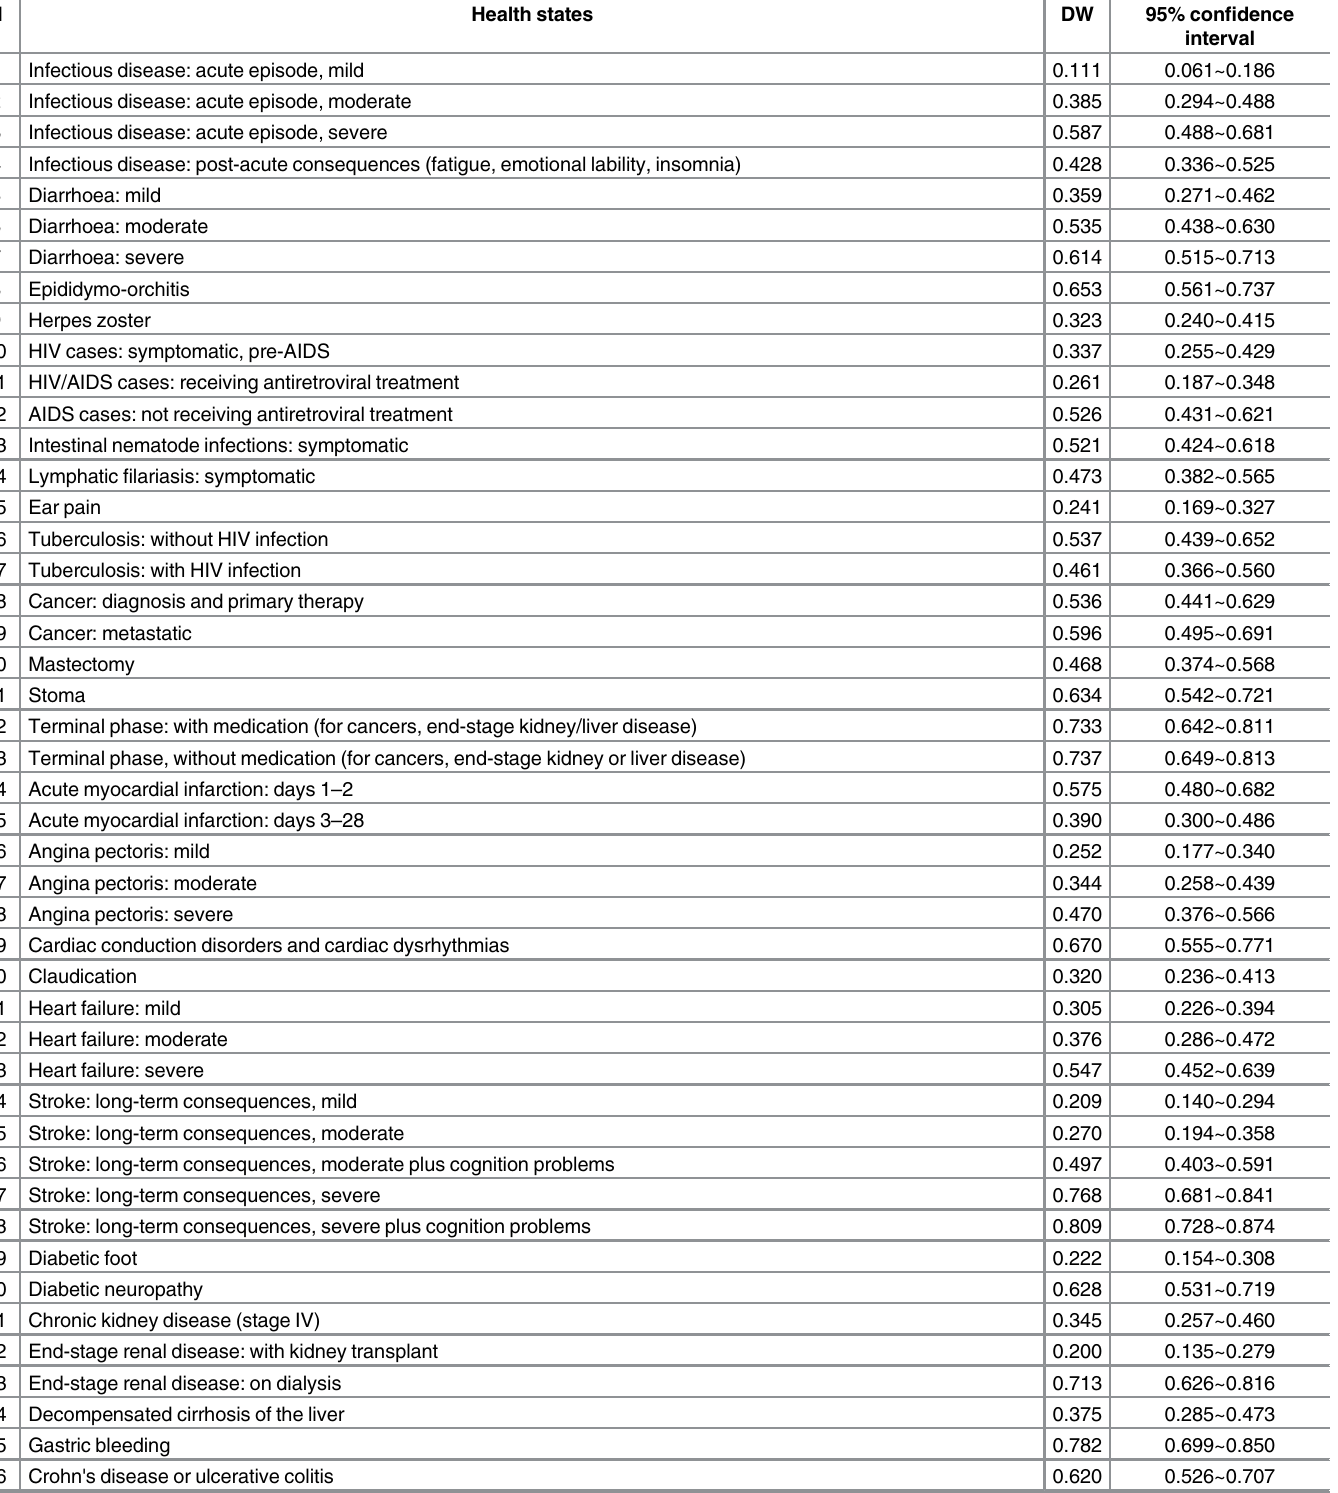
Table 4. Confidence intervals of the disability weights from the paired comparison-only